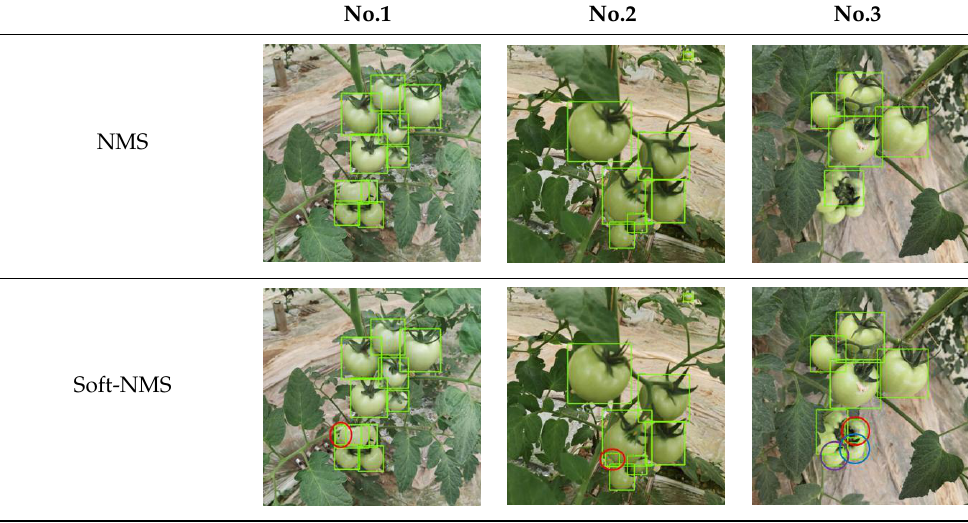
Table 5. Performance of different Non-Maximum Suppression algorithms.